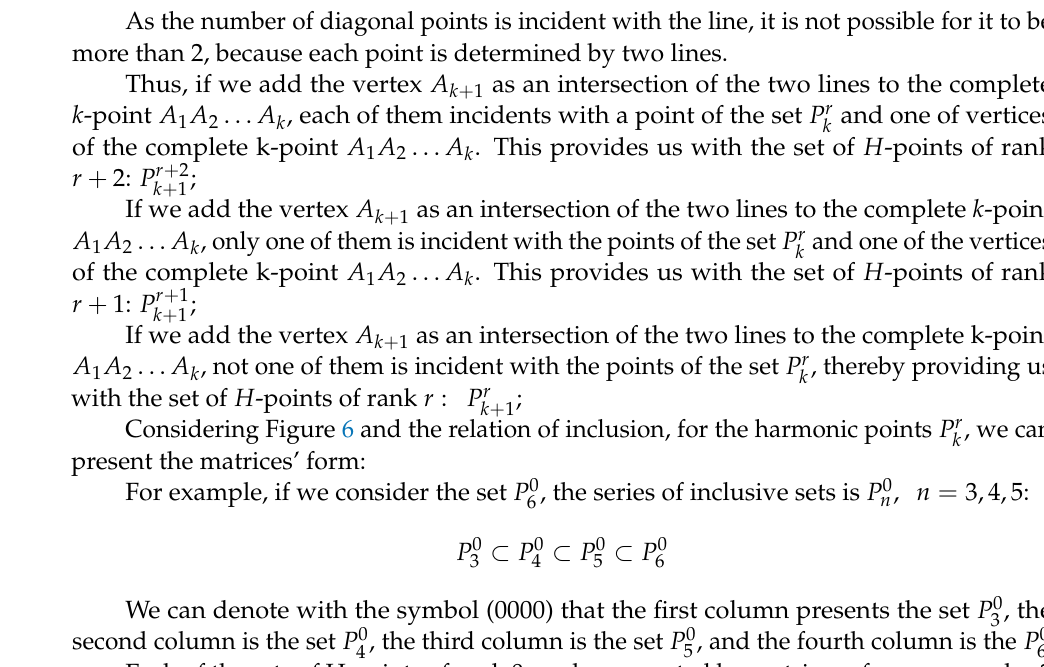
Figure 6. The structure of generalized harmonic points.